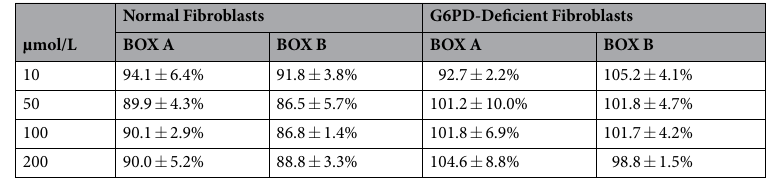
Table 1. Viability of human skin fibroblasts and G6PD-deficient fibroblasts exposed to BOX A and BOX B for 4